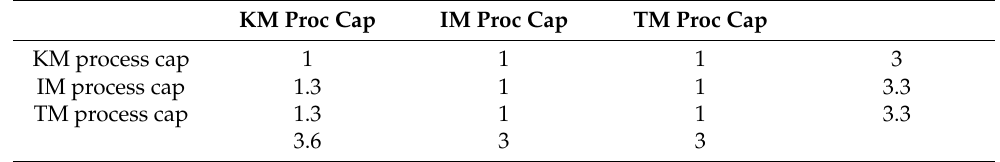
Table 7. Total relation matrix T (Dimension) .